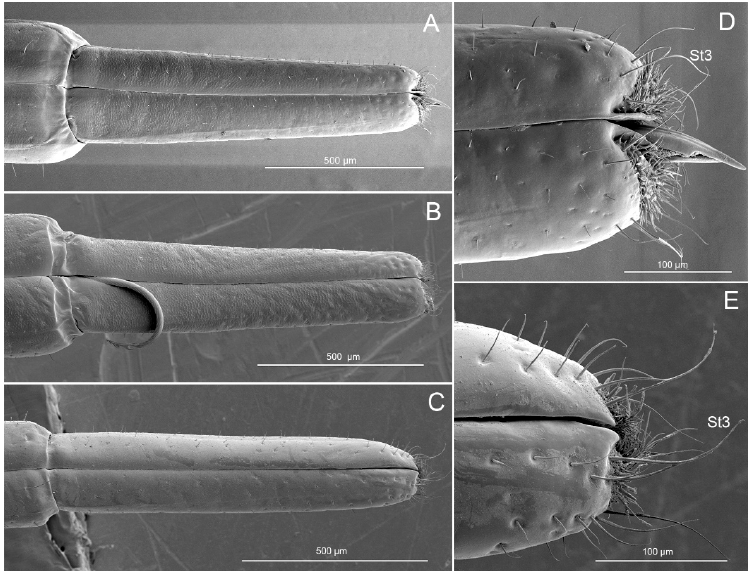
Figure 8. SEM images of ventral view of the fourth labial segment. ( A ) Ventral view of Picromerus bidens ; ( B ) Ventral view of Picromerus lewisi ; ( C ) Ventral view of Cazira bhoutanica ; ( D ) Apex of the fourth labial segment of Picromerus bidens ; ( E ) Apex of the fourth labial segment of Cazira bhoutanica, St3, sensilla trichodea III.